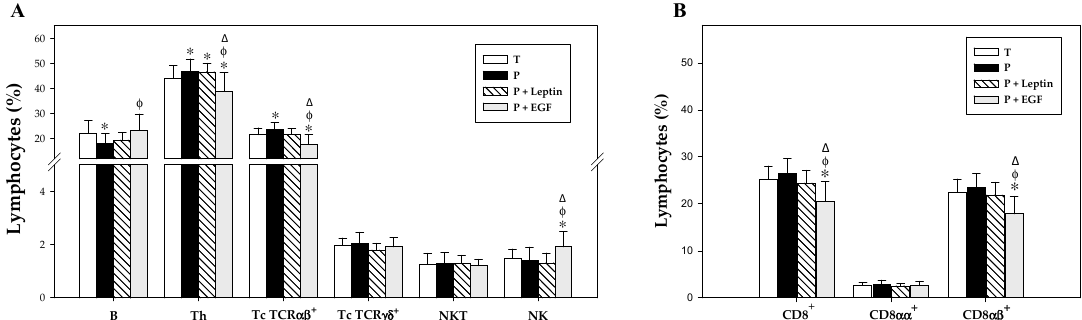
Figure 6. Main lymphocyte subsets ( A ) and CD8 + cells and their both forms (CD8 αα + and CD8 αβ + ) cell percentages ( B ) in the mesenteric lymph nodes (MLNs) from the four groups: Term (T), Preterm (P), P + Leptin, and P + epidermal growth factor (P + EGF) at day 17. The results are expressed as mean ± SD ( n = 8–12 pups/group). Statistical differences: * p < 0.05 versus T group; φ p < 0.05 versus P group; Δ p < 0.05 versus P+Leptin group.